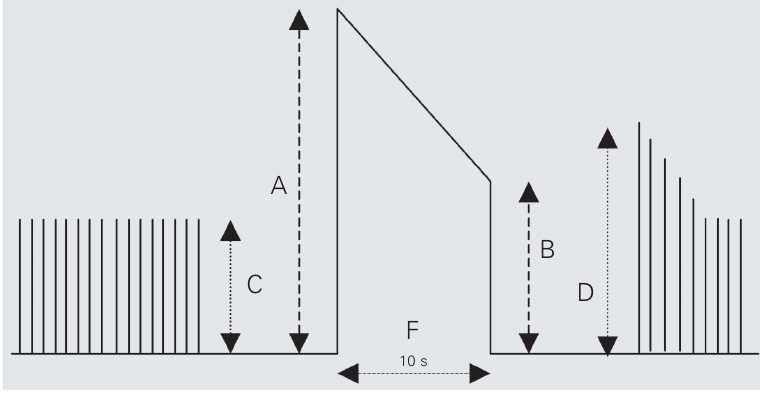
Figure 2. Percentage of reduc- tion in R-values induced by L- carnitine (A), DL-carnitine (B) and D-carnitine (C), 30 and 60 µM, in indirectly stimulated neu- romuscular preparations. The R- ratio is reported on the ordinate as percent of that obtained in drug-free Krebs buffer, taken as 100% (t = 0). The drugs were added at t = 0. W indicates re- placement of drug-free Krebs buffer (four times). Each point represents the mean ± SEM of 6 experiments. *P < 0.05 com- pared to control (Student t